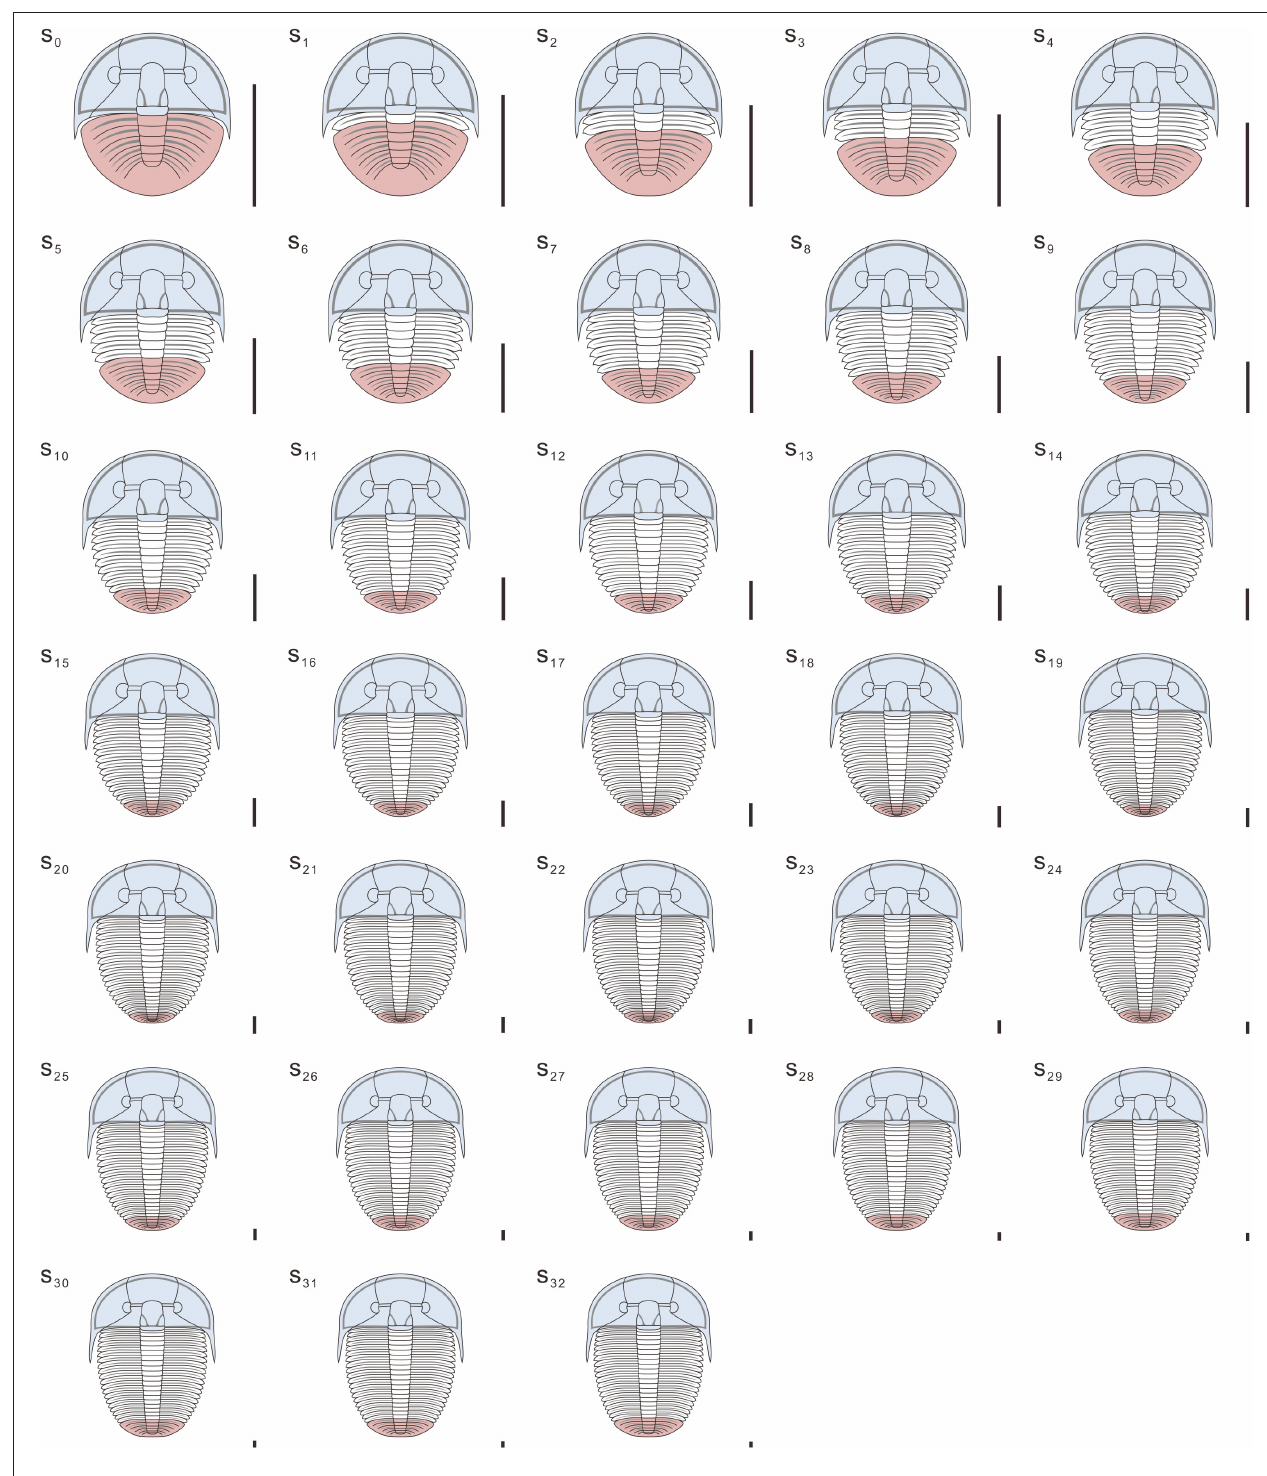
FIGURE 5 | Meraspid (stages s 0 –s 19 ) and holaspid (stages s 20 –s 32 ) ontogeny of A. koninckii morphotype t 20 . All stages are shown at the same size (body length), so as to highlight shape changes with growth. Scale bars = 1 mm. A schematic view of the same ontogeny is shown in Figures 6 , 7 .